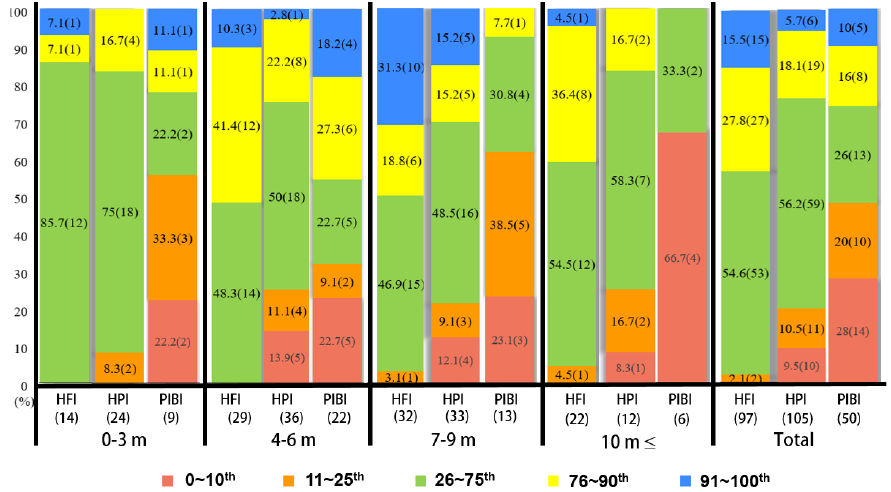
Figure 1. Distribution of five percentile categories of motor performance using the AIMS total score among three groups. HPI: healthy preterm infants, PIBI: preterm infants with brain injury, and HFI: healthy full-term infant. Age was calculated with corrected age or chronological age.